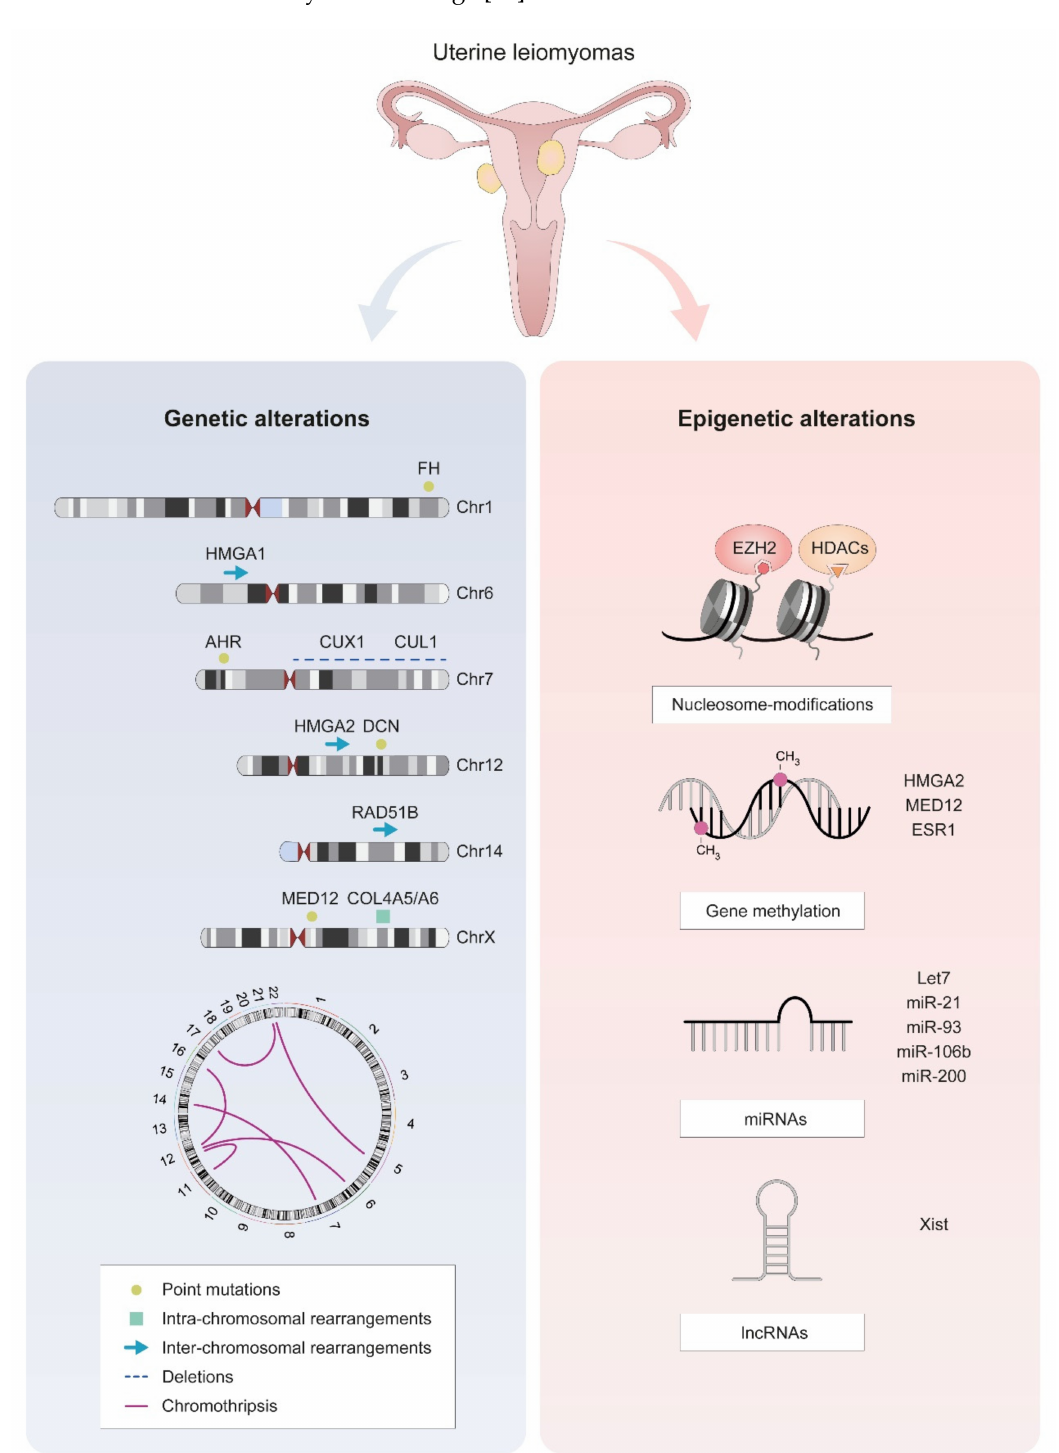
Figure 2. The most frequent molecular alterations in uLM cells. Genetic alterations are represented on ideograms of the most frequently affected chromosomes, along with a scheme of HMGA1/2-RAD51B and a circos plot representing chromothripsis. Epigenetic alterations include disrupted nucleosome modification, gene methylation, and altered expression of non-coding